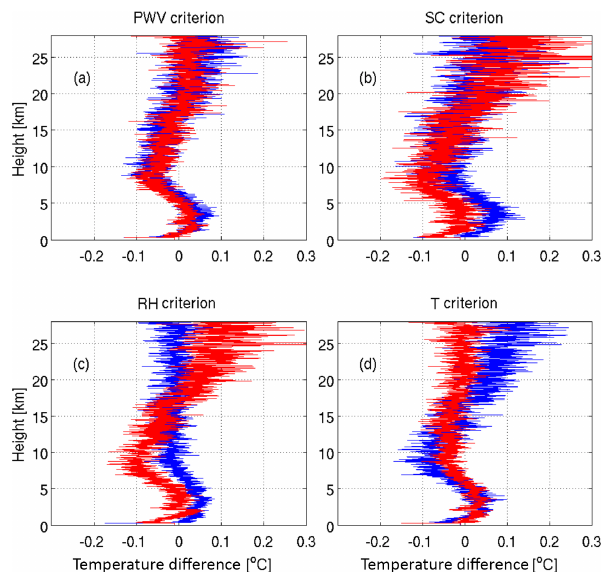
Figure 14. Temperature difference between RS92 and RS41 ra- diosondes (RS92 − RS41) as a function of height for sonde launches with (a) PWV > 3.63cm (blue) and those with PWV < 3.63cm (red), (b) SC > 41.45% (blue) and SC < 41.45% (red), (c) surface RH > 65% (blue) and surface RH < 65% (red), and (d) surface temperature > 26.2 ◦ C and surface temper- ature < 26.2 ◦ C (red). The PWV, SC, RH, and T = of 3.63cm, 41.45%, 65%, and 26.2 ◦ C, respectively, are based on the median values for the 20 balloon launches during the